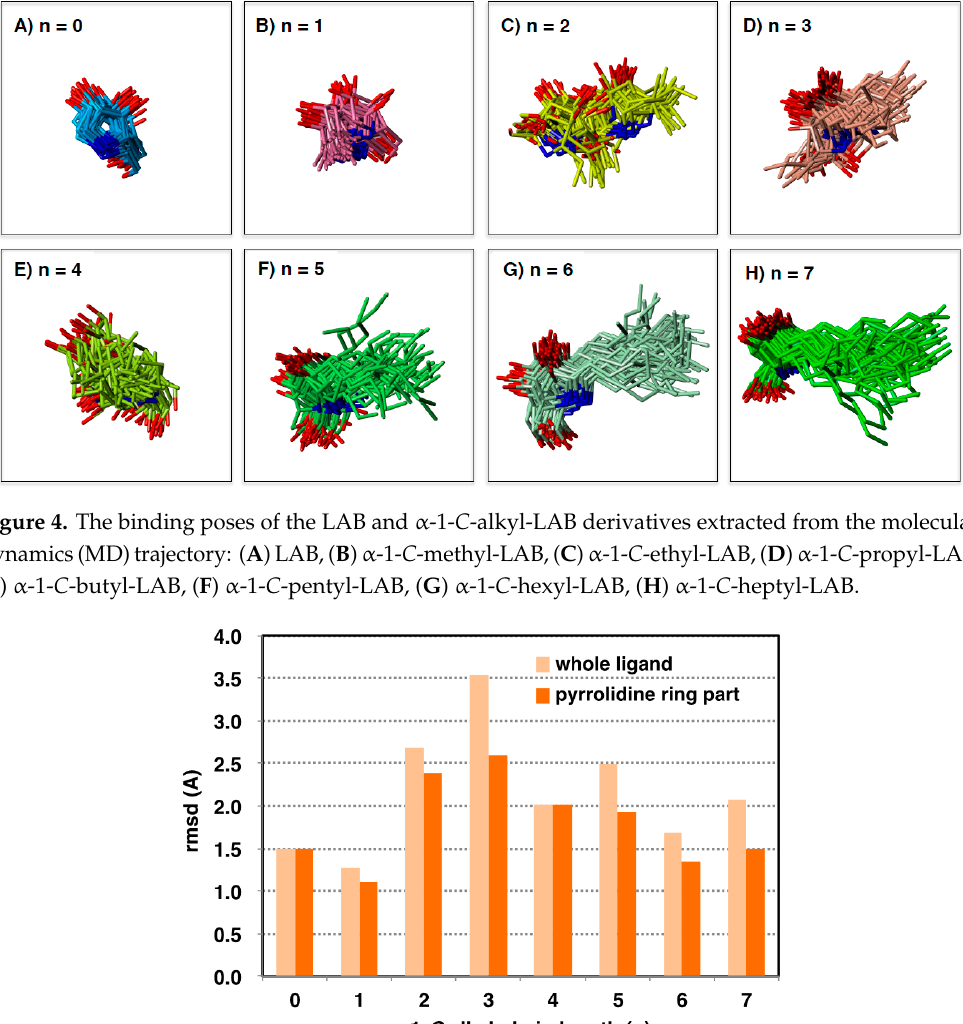
Figure 5. Effect of alkyl chain length on variation of ligand binding pose on GAA. Light orange: whole ligand (excluding hydrogen). Orange: pyrrolidine ring part (excluding hydrogen). Root mean square deviation (RMSD) value calculated for 50 extracted from 24 ns to 48 ns.